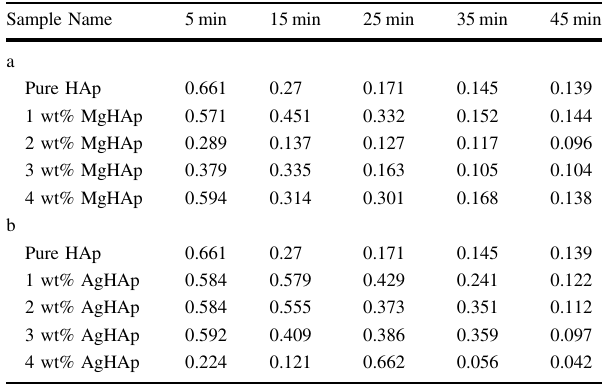
Table 5 a: The clotting time of various weight percents MgHAp samples. b: The clotting time of different weight percents of AgHAp